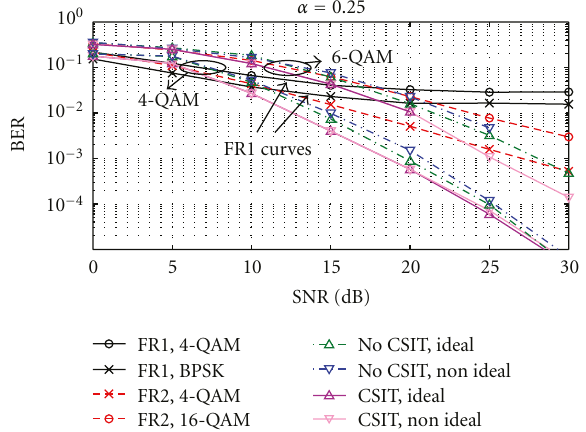
Figure 5: Bit error rate (BER), as a function of the SNR (dB), for two isolated base stations. The link quality is α = 0 . 25, and the modulation is 4-QAM and 16-QAM, respectively. The FR1 curves denote the direct transmission scheme with BPSK and 4-QAM modulation, respectively. The non ideal link denotes the case when the base station-to-base station link gain is β = α